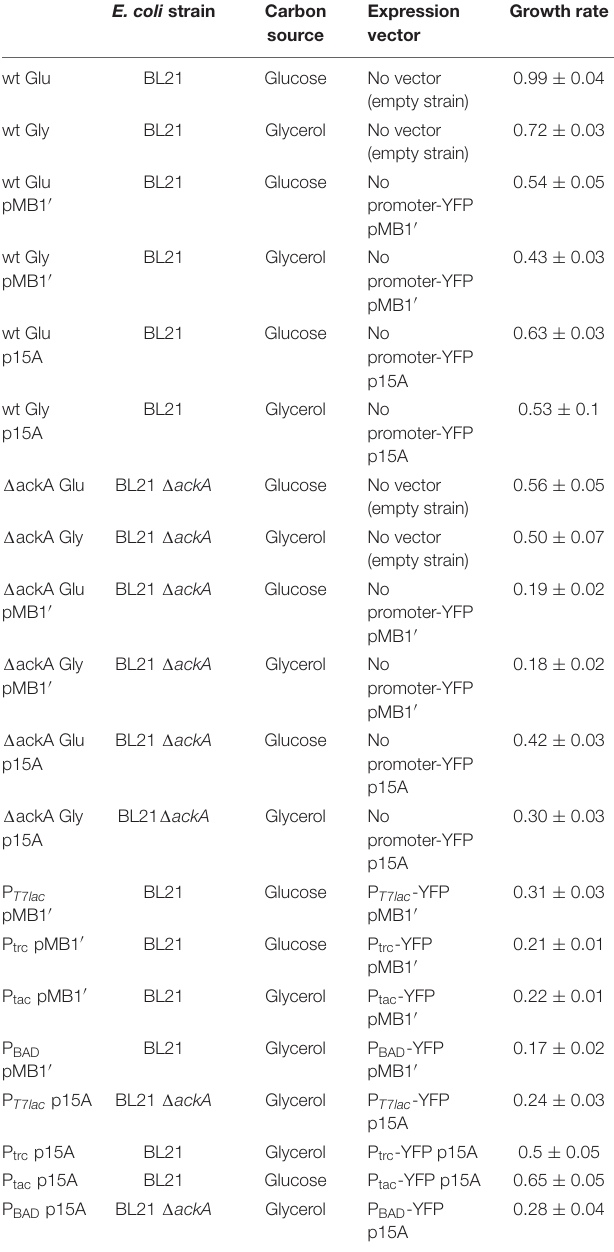
TABLE 3 | Growth rates calculated for empty strains and containing promoterless vectors growing with glucose or glycerol as carbon sources. E. coli